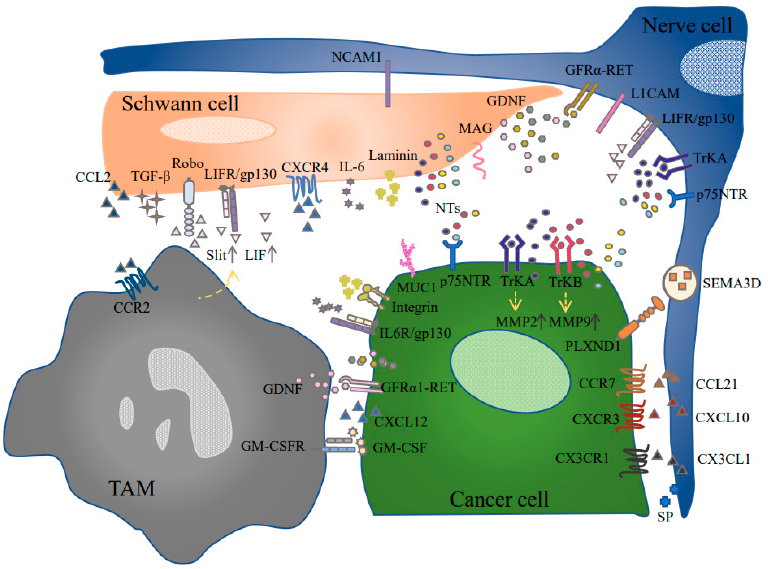
Figure 1. The complicated crosstalk between different types of cells in TME. Various signaling molecules participate in the interaction, thereby transforming the cell structure and function and facilitating the malignant development of PDAC. GDNF, glial cell line-derived neurotrophic factor; GFR α -RET, glial cell line-derived neurotrophic factor family receptor- α -rearranged during transfection; GM-CSF, granulocyte–macrophage colony-stimulating factor; GM-CSFR, granulocyte–macrophage colony-stimulating factor receptor; IL6R/gp130, interleukin-6 receptor/glycoprotein 130; L1CAM, L1 cell adhesion molecule; LIF, leukemia inhibitory factor; LIFR/gp130, leukemia inhibitory factor receptor/glycoprotein 130; MAG, myelin associated glycoprotein; MUC1, mucin 1; NCAM1, neural cell adhesion molecule; NT, neurotrophin; p75NTR, p75 neurotrophin receptor; PLXND1, plexin-D1; Robo, Roundabout; SEMA3D, semaphorin 3D; SP, substance P; TAM, tumor-associated macrophage; TrKA, tropomyosin receptor kinase A; TrKB, tropomyosin receptor kinase. Clinical data indicate that high level of intratumoral Schwann cell marker GFAP/S100